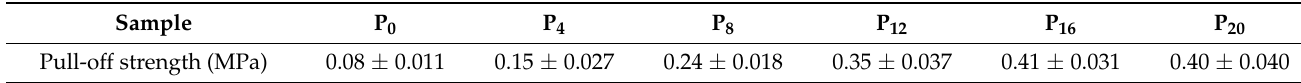
Table 3. The pull-off strength of the prepared coatings.